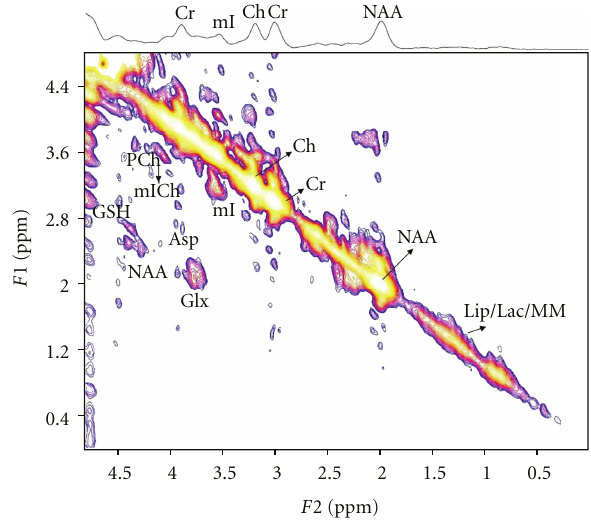
Figure 2: A representative 2D L-COSY spectrum of a 64 years old HCV+ patient.